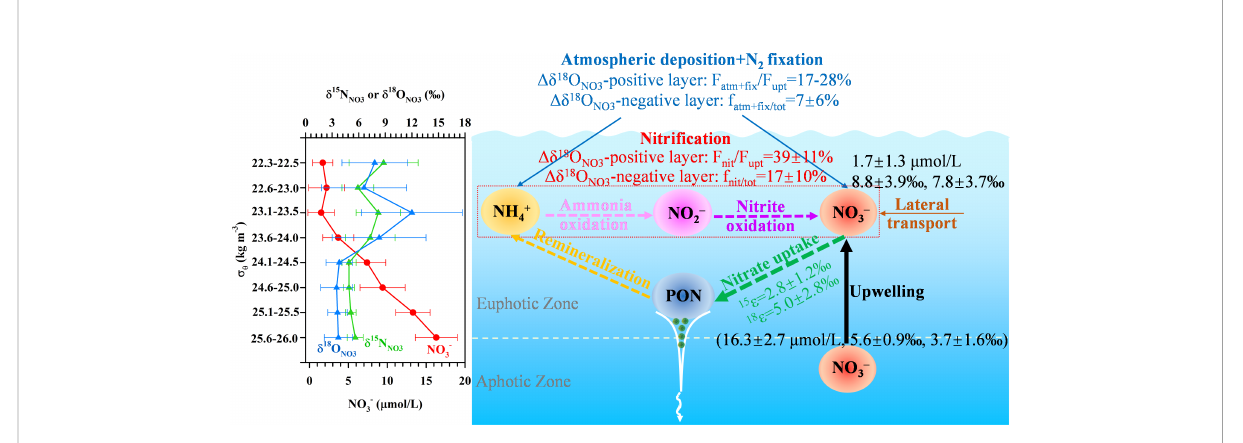
FIGURE 3 Conceptual diagram for NO 3 – dynamics in the upper water column of the